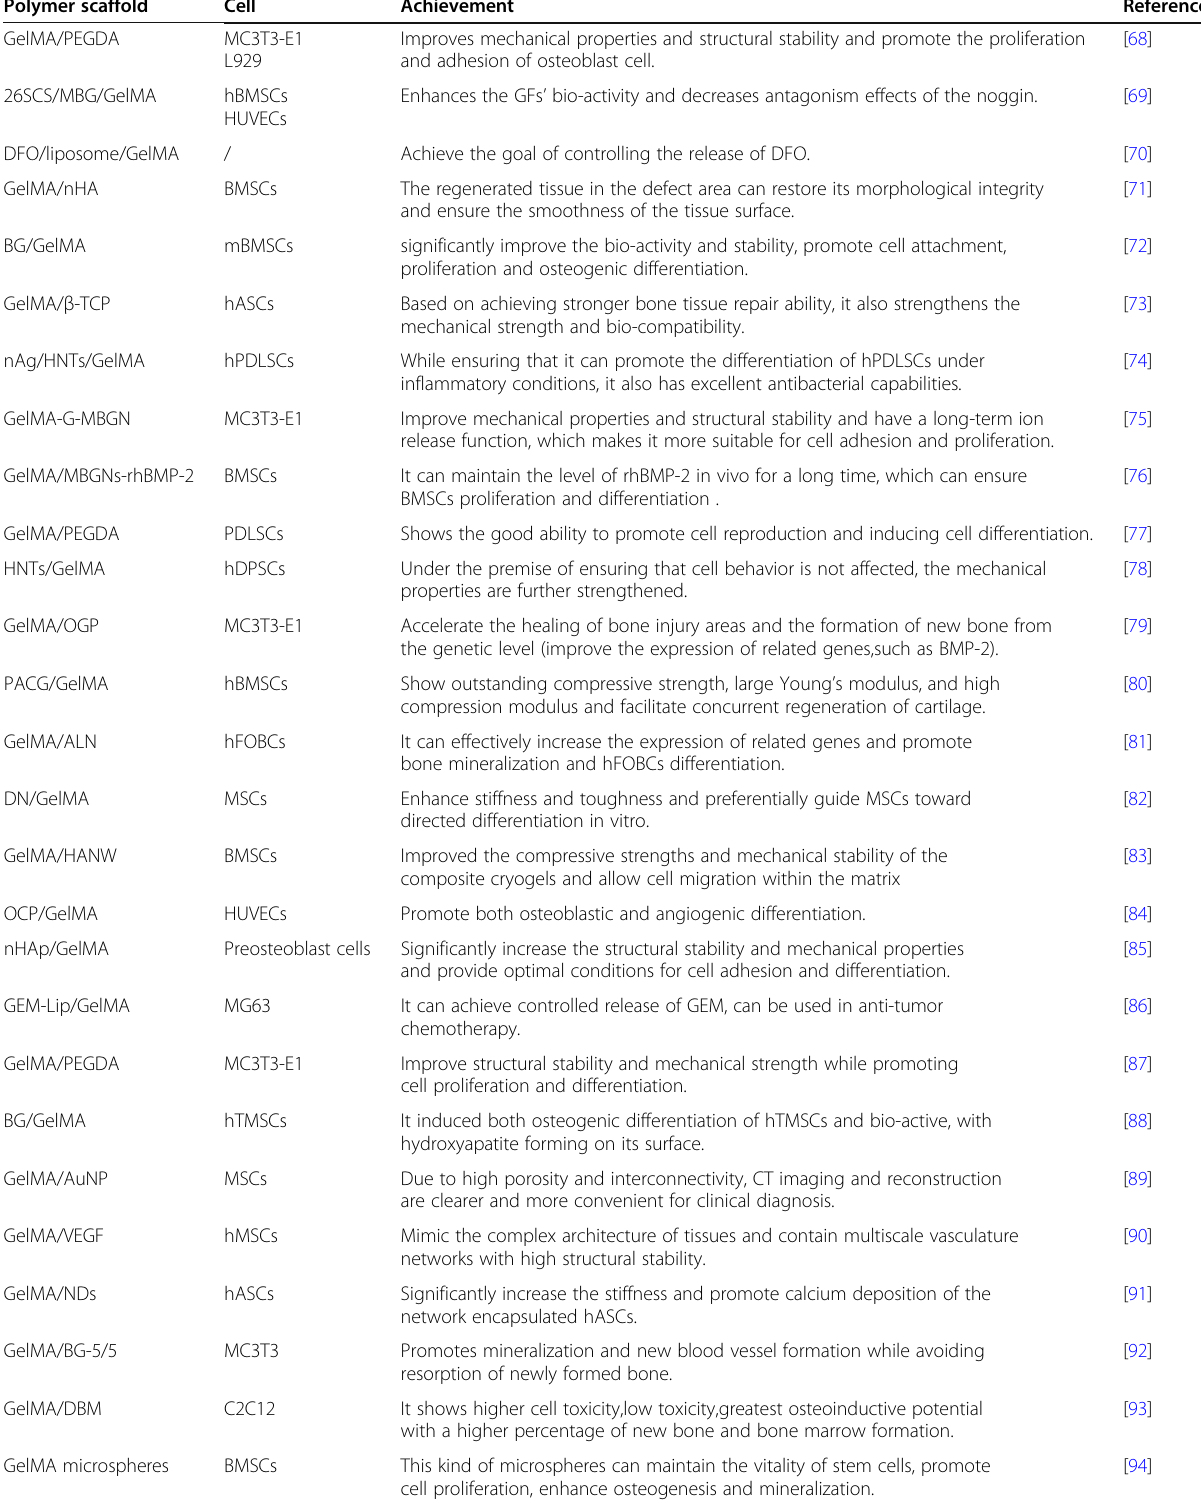
Table 3 The recent applicati on of GelMA in bone tissue regeneration Polymer